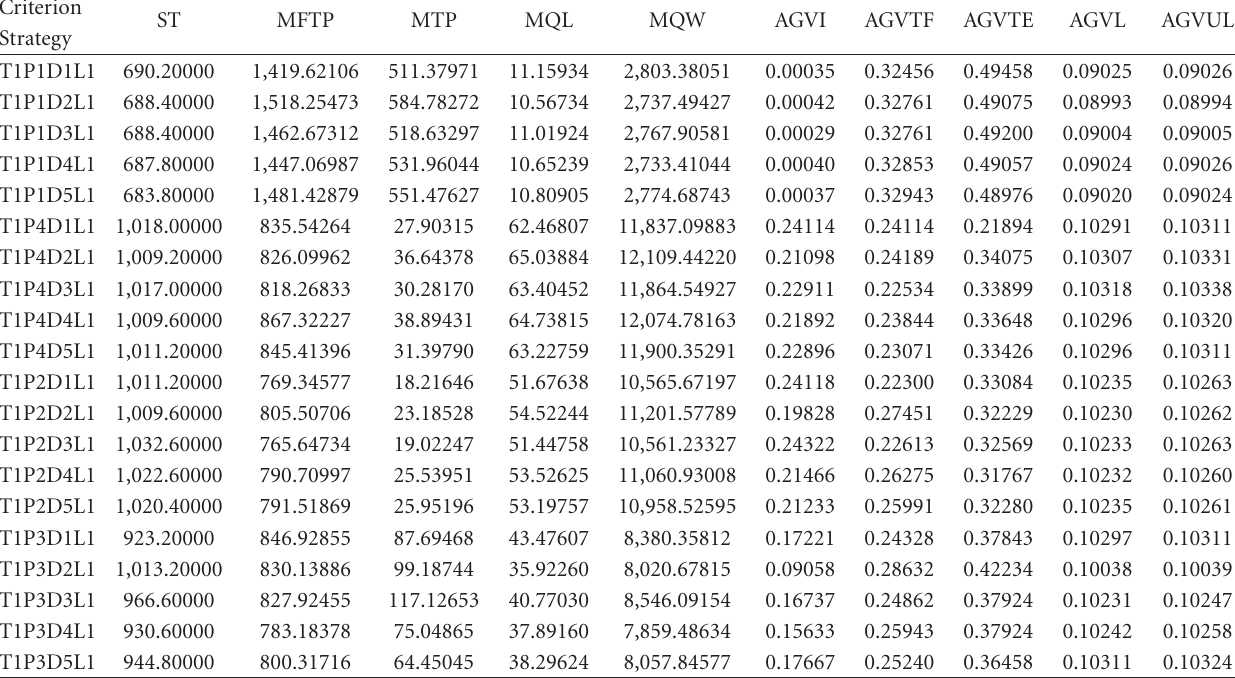
Table 7: Simulation